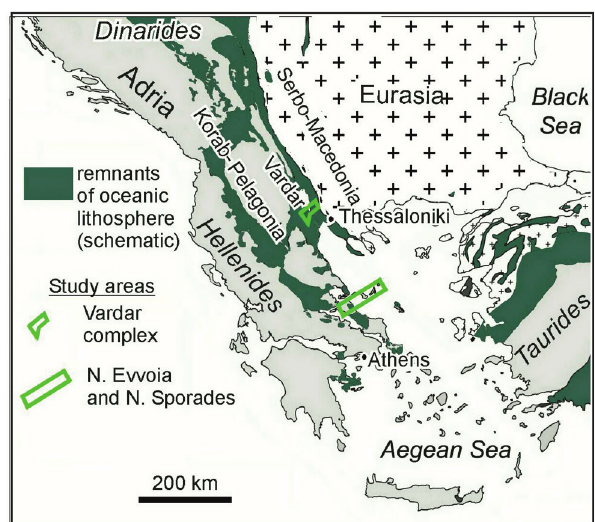
Neotethys oceanic lithosphere in the Dinarides through the Hellenides and Taurides, represent remnants of the northern branch of the Neotethys (altered after Ustaszewski et al. [12]). Our study areas are in Evvoia and the Northern Sporades, and in the ‘Vardar zone’ of Greek Macedonia. Fieldwork was carried out in the Vardar zone and Northern Evvoia in September and October 2020 and Evvoia and the Northern Sporades in previous